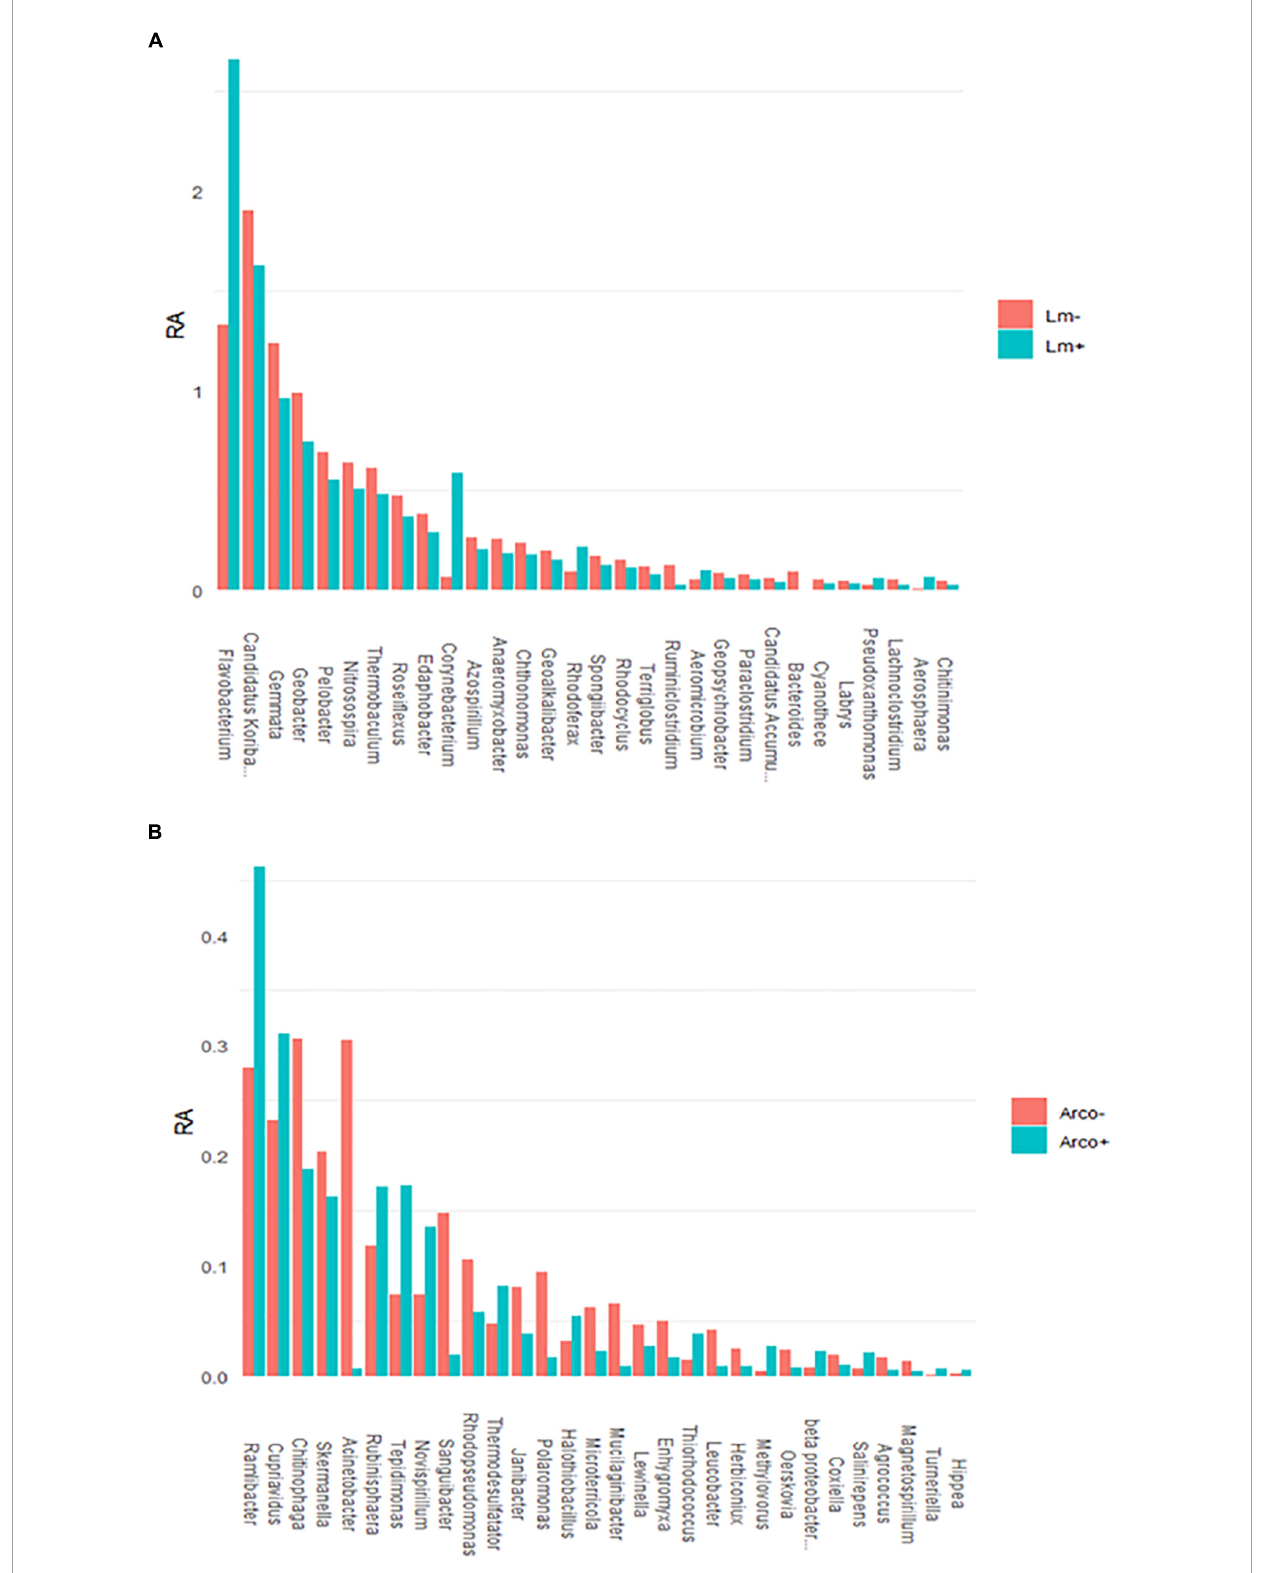
FIGURE11 Top thirty genera detected (16S) with significant differences between their mean relative abundance (%) when comparing Arcobacter negative (–) and positive (+) OH soil samples (A) and between Lm negative (–) and Lm positive (+) OH soil samples (B) . Genera names were truncated at twenty characters. Bacteriodes RA in Lm+ samples was 0.000883. RA, mean relative